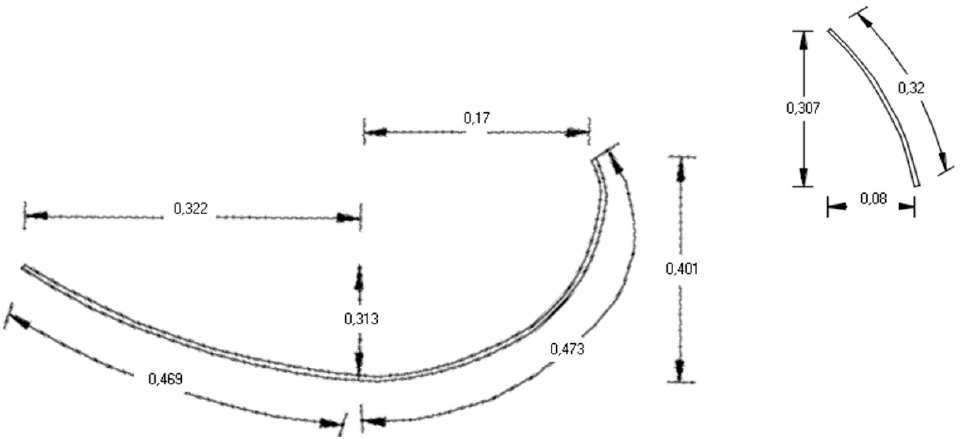
Figure 6. Optimum dimensions (in m) for the design reflector parabolic parts ( AB ) and ( C’A’ ).